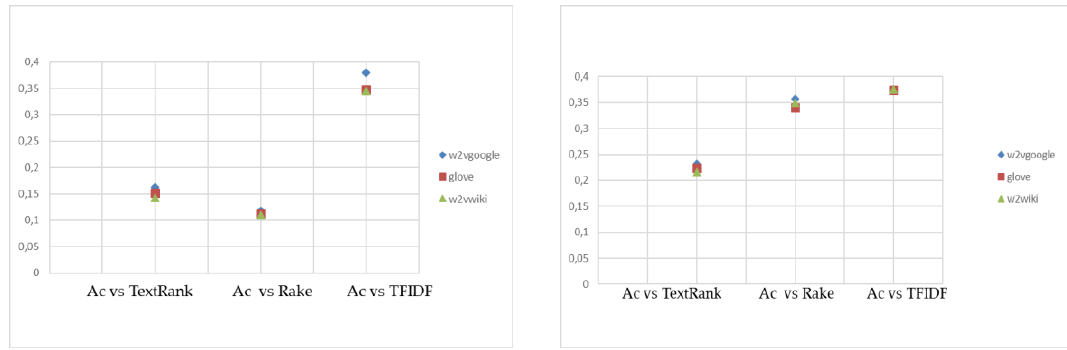
Figure 7. Comparison of results of this method (using hierarchical clustering and Cosine similarity) with baseline on 1-g (on the left) and n -grams (on the right).